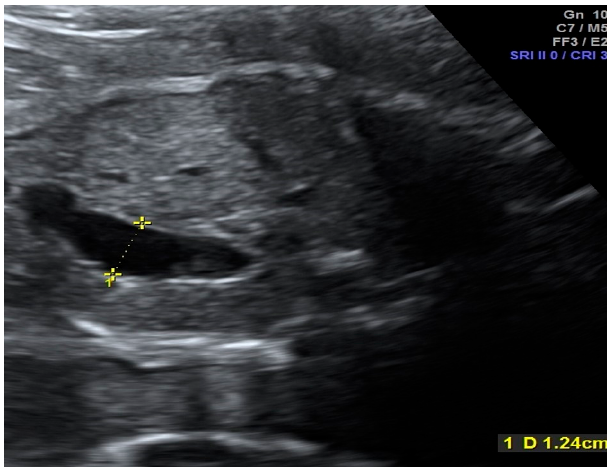
abdominal bowel dilatation (EABD).